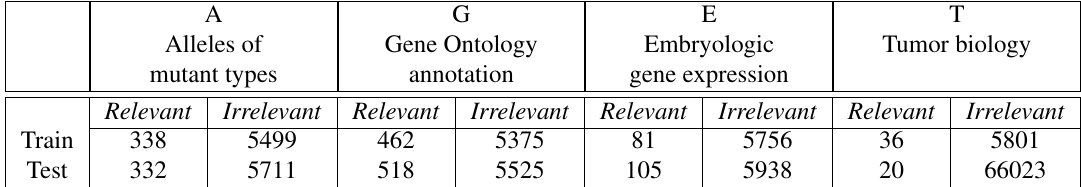
Table 1: TREC 2005 Genomic track corpora